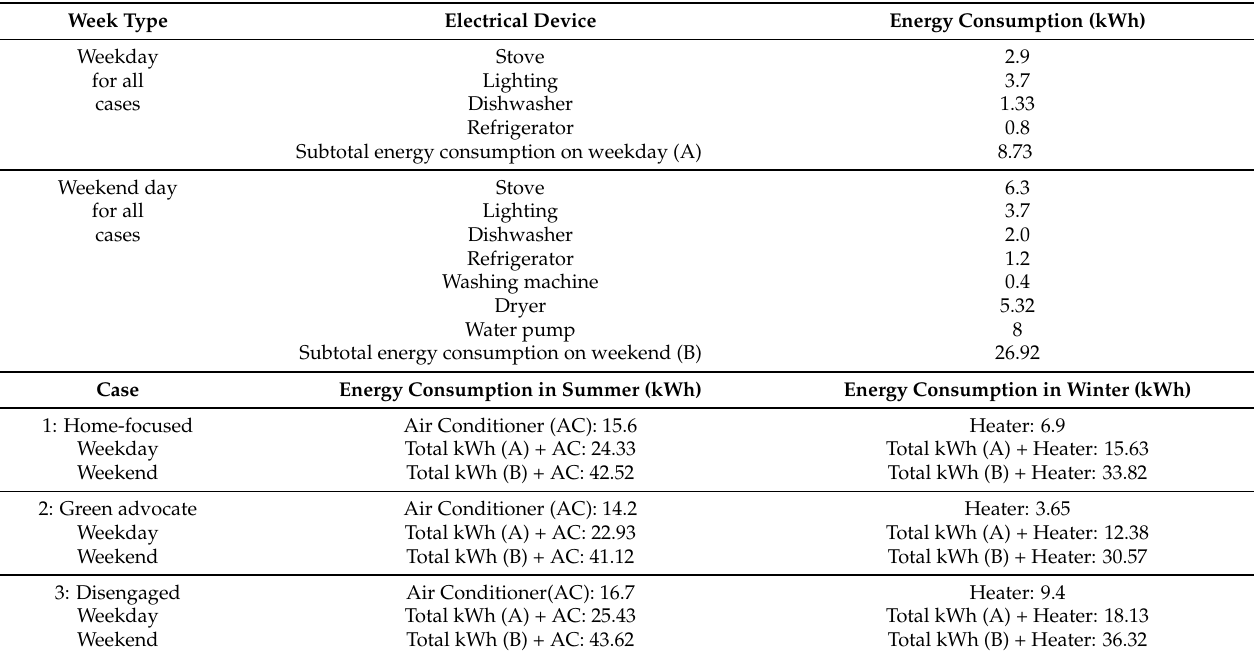
Table 5. Average daily weekday and weekend day electrical consumption profile in winter and summer with different thermal comfort